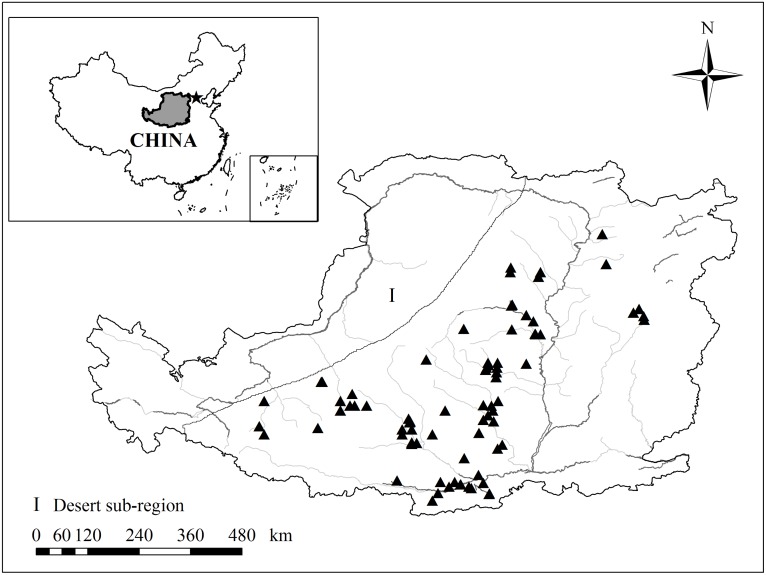
Location of the Loess Plateau in China and the distribution of sampling sites on the Loess Plateau.